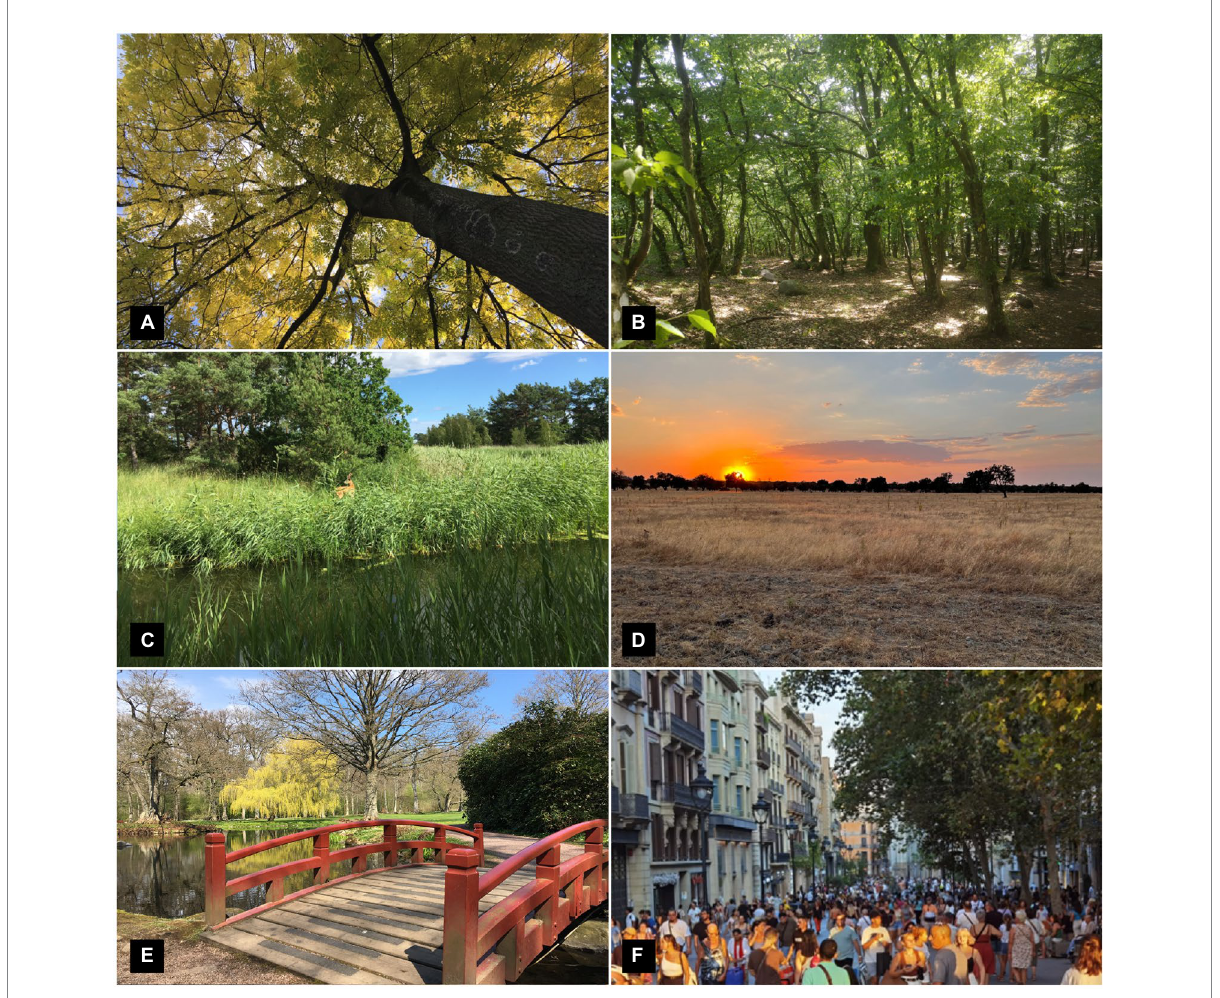
FIGURE 2 Examples of PSDs and their possible developmental roots. (A) Fundamental aspects of how we perceive and interact with the Natural world can be traced to adaptations to an arboreal life. (B) A human affinity for extended Cohesive settings could stem from adaptations to a life on the forest floor. (C) Adaptations to structural and biological diversity in forest edge zones might form the evolutionary basis for the Diverse PSD. (D) The Open PSD, with expanded vistas and plenty of room to roam, could reflect adaptions to a hunter-gatherer lifestyle in increasingly open settings. (E) The Cultural PSD, characterised by the distinct traces of human creative efforts, primarily reflects cultural evolution and adaptations to increasingly human-altered environments. (F) Although our highly social nature might reflect ancient primate traits, it is through the relatively recent urbanisation that Social affordances have increased to a previously unprecedented degree. (Photos by the